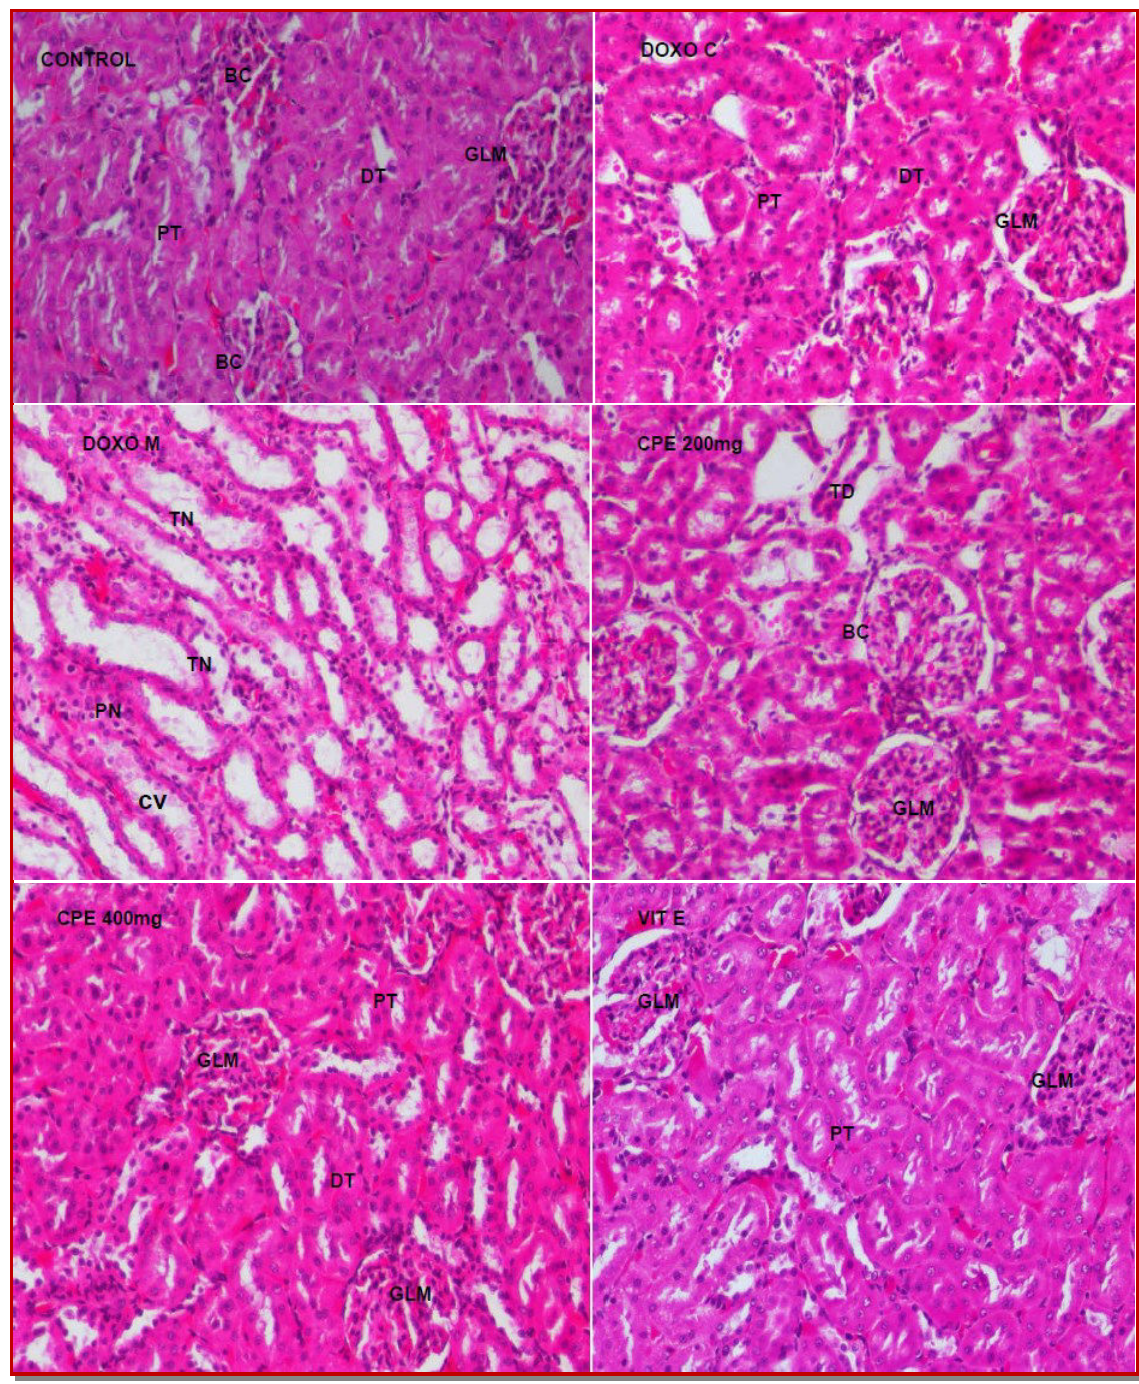
Figure 1: Shows the histological changes observed in the kidney of rats in the different treatment groups CONTROL: The kidney shows normal architecture with intact glomerulus (GLM) and Bowman’s capsule (BC). Proxiaml tubules (PT) a nd Distal tubules (DT) appear normal with tubular cells intact. Nuclei of the tubular cells are normal. DOXO C: Glomerular congestion, inc reased Bowman’s space, tubular necrosis and lymphocytic infiltration were noted in the cortical region. DOXO M: Medullary region shows tubular degeneration (TD), cytoplasmic vacuolation (CV) and pyknotic nuclei (PN). CPE200 mg: Mild to moderate degeneration of the tubular cells. Glomerular congestion is mild. CPE 400 mg: Glomerulus appear normal with reduced space. Proximal and distal tubules exhibit normal histology. Mild tubular degeneration at focal areas is noted.VIT E: Glomerulus and Bowman’s capsule appear normal. Tubular cells are normal. Mild focal necris of the tubular cells is